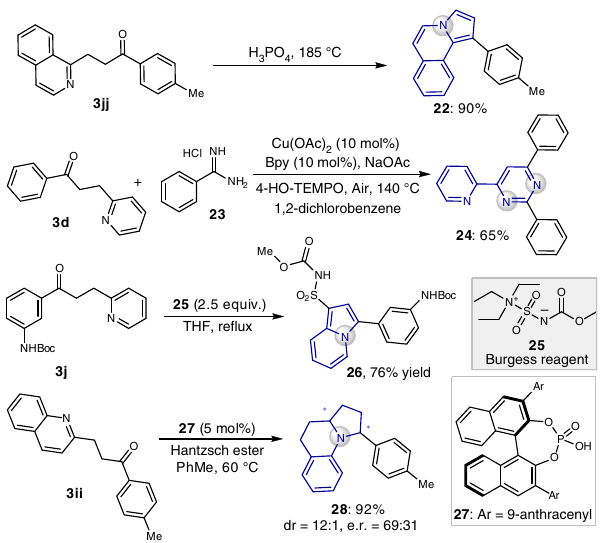
Fig. 7 Downstream transformations